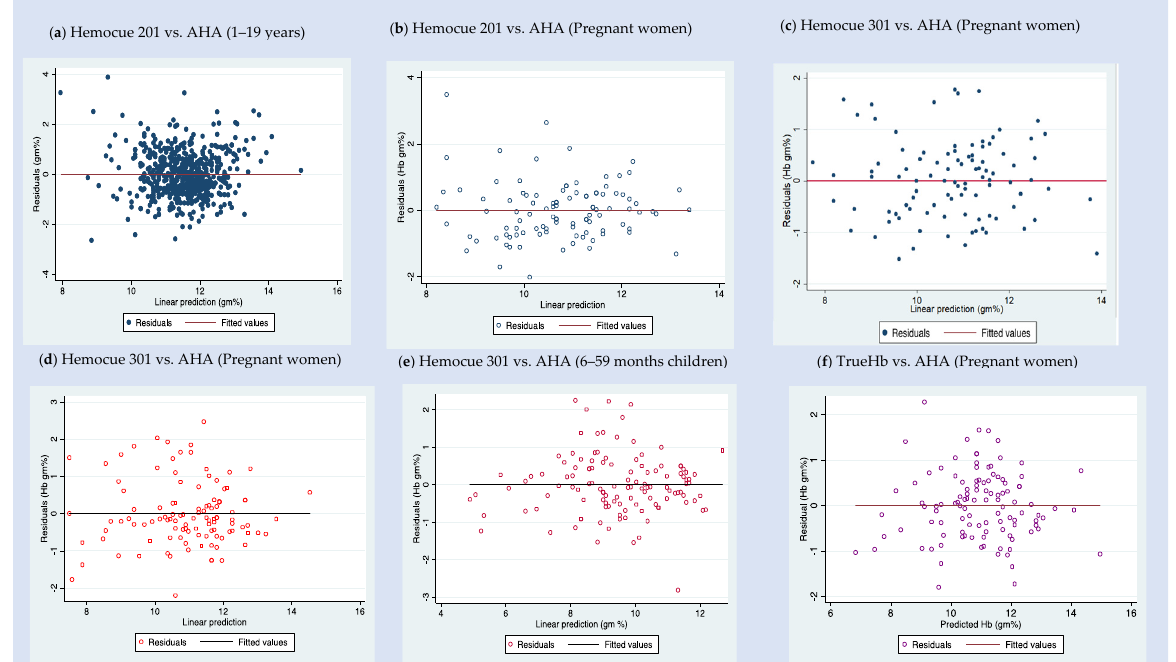
Figure 2. Plots of predicted vs. observed hemoglobin residual values for fixed ratio model based on the data subsets from India—residual plots of ( a ) Hemocue 201 (POCT) vs. AHA among 1–19-year-old children—dataset D; ( b ) Hemocue 201 (POCT) vs. AHA among pregnant women—dataset A; ( c ) Hemocue 301 (POCT) vs. AHA among pregnant women—dataset A; ( d ) Hemocue 301 (POCT) vs. AHA among pregnant women—dataset B; ( e ) Hemocue 301 (POCT) vs. AHA among 6–59-month-old children—dataset C; and ( f ) TrueHb hemometer (POCT) vs. AHA among pregnant women—dataset B.